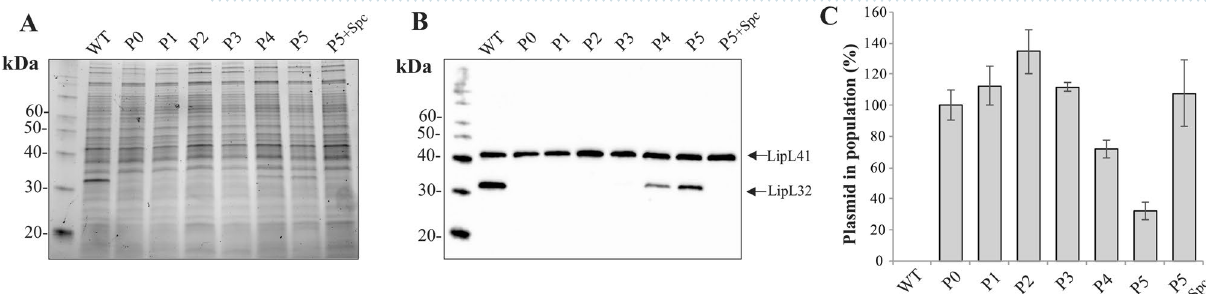
Figure 4. Evaluation of phenotypic stability of gene silencing. Protein extracts from wild type L . interrogans (WT) or recombinant cells containing pMaOri.dCas9sg32 were evaluated by SDS-PAGE ( A ) and immunoblotting ( B ). Recombinant cells were grown in the presence of spectinomycin, P0, and then serially grown in liquid HAN with no antibiotic pressure selection (P1–P5). Addition of spectinomycin at passage 5 (P5 + Spc) fully restored gene silencing. Genomic DNA of cells at each passage was evaluated by qPCR with primers specific for the pMaOri backbone and the lipL32 primer set was employed as an internal control ( C ). Results are expressed as a % of plasmid in the total population, where P0 was considered